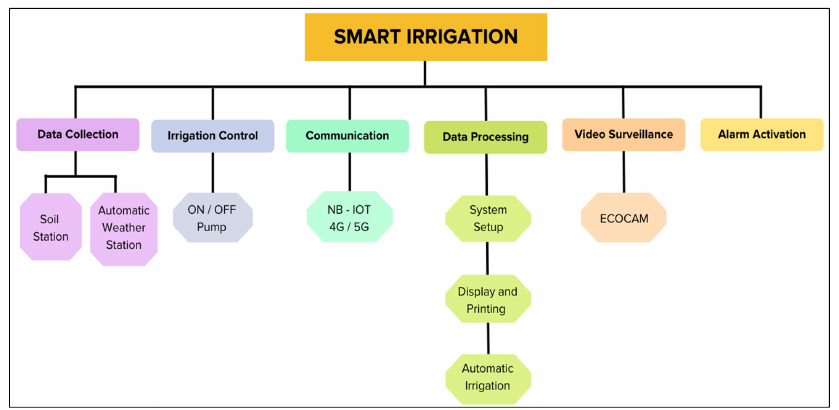
Figure 7. Flow diagram of various components and processes of smart irrigation systems.